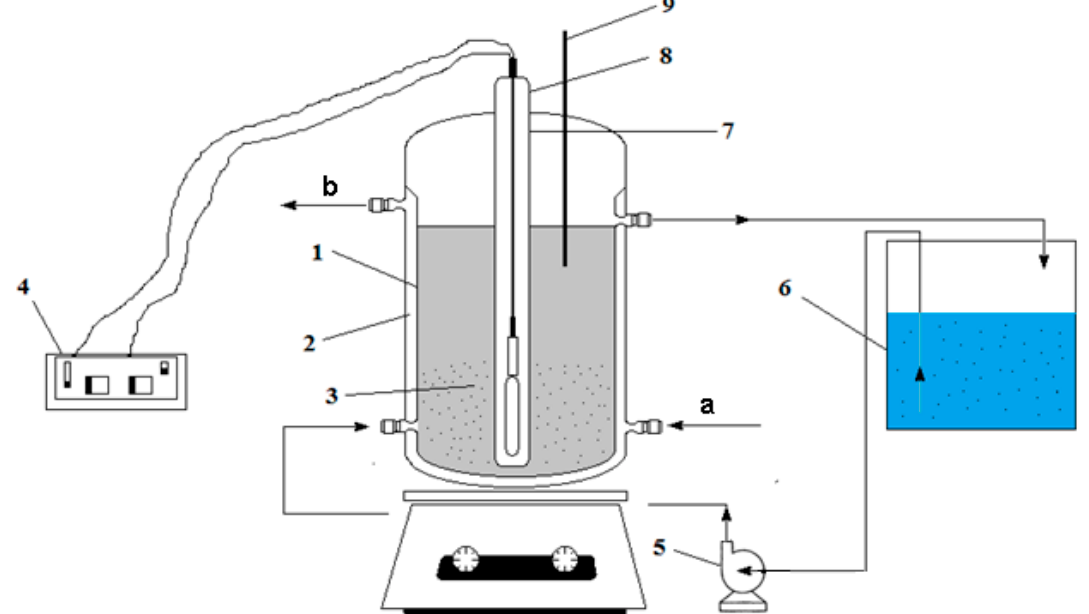
Figure 2. Laboratory installation composed of the following elements: 1—photocatalytic reactor; 2—cooling jacket (a, b); 3—Fe 3 O 4 or Fe 3 O 4 /PVA (modified composite); 4—UV lamp source; 5—recirculation pump; 6—recirculation reservoir; 7—UV lamp; 8—quartz tube; 9—thermometer.